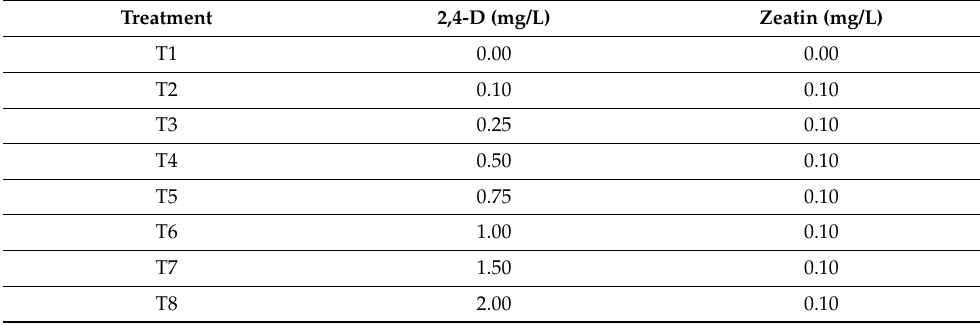
Table 1. Plant growth hormones added in MS media used for callus induction in stevia.